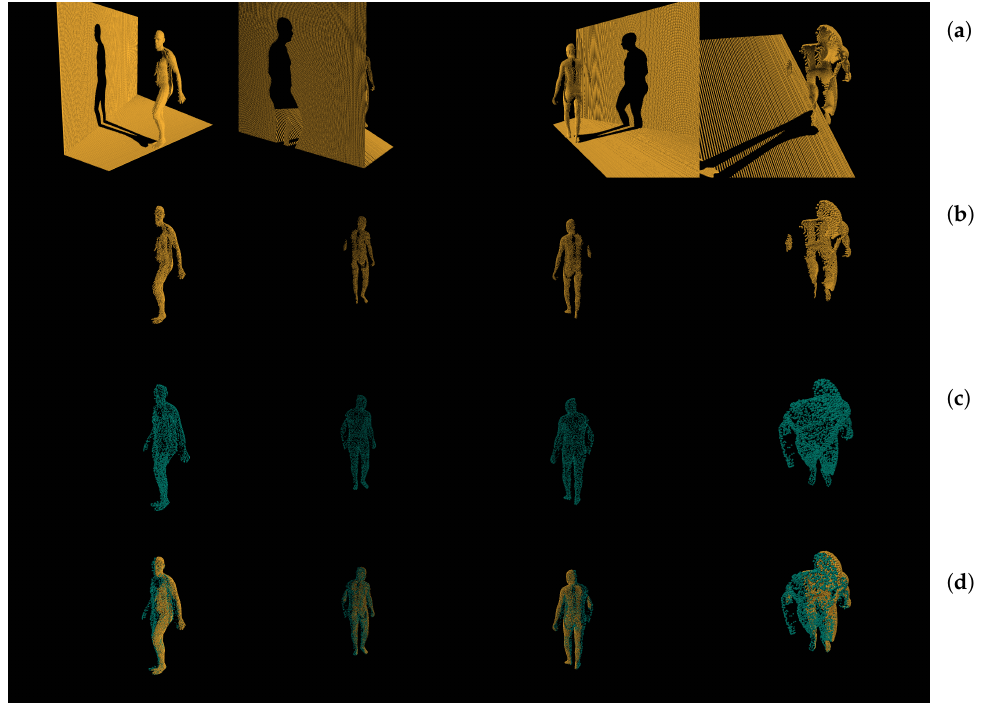
Figure 7. Different viewpoints of same pointclouds. Contains stacked from top to bottom: ( a ) input pointcloud; ( b ) clipped and sampled pointcloud; ( c ) predicted pointcloud; ( d ) combined ( b , c ).